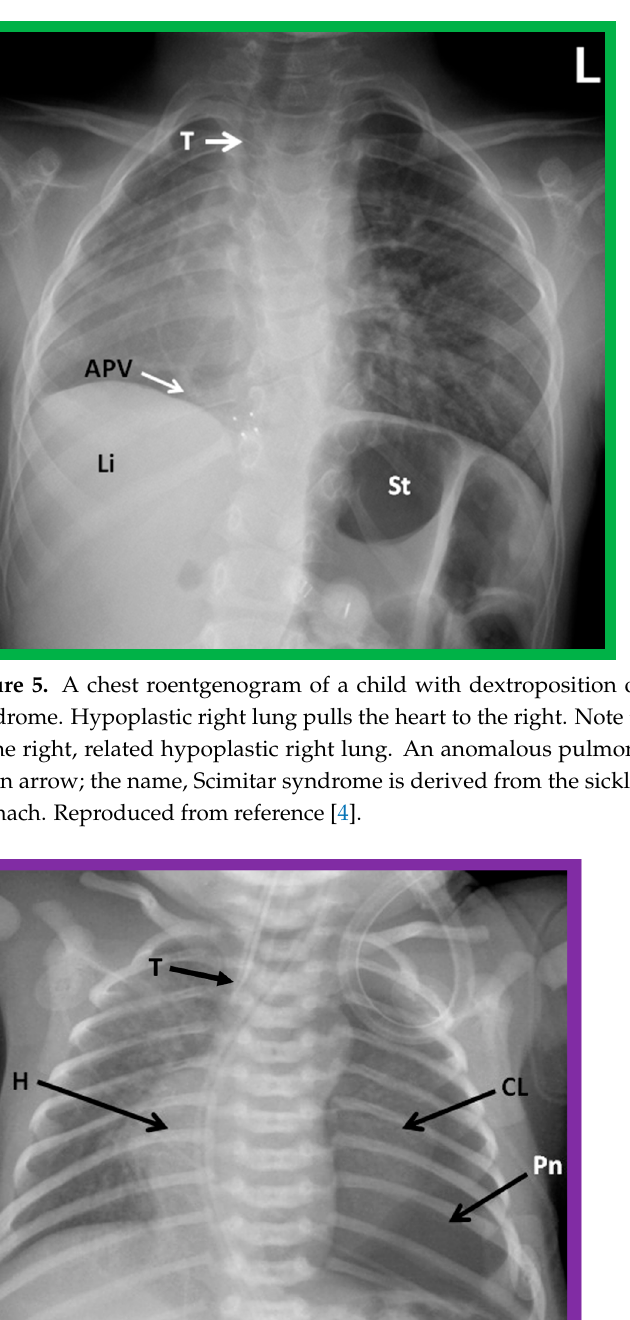
Figure 7. A chest roentgenogram of an infant demonstrating dextroposed heart (H) secondary to diaphragmatic hernia on the left side. The abdominal contents, including intestines (In) are relocated to the left side of the chest because of the diaphragmatic defect, pushing the heart into the right